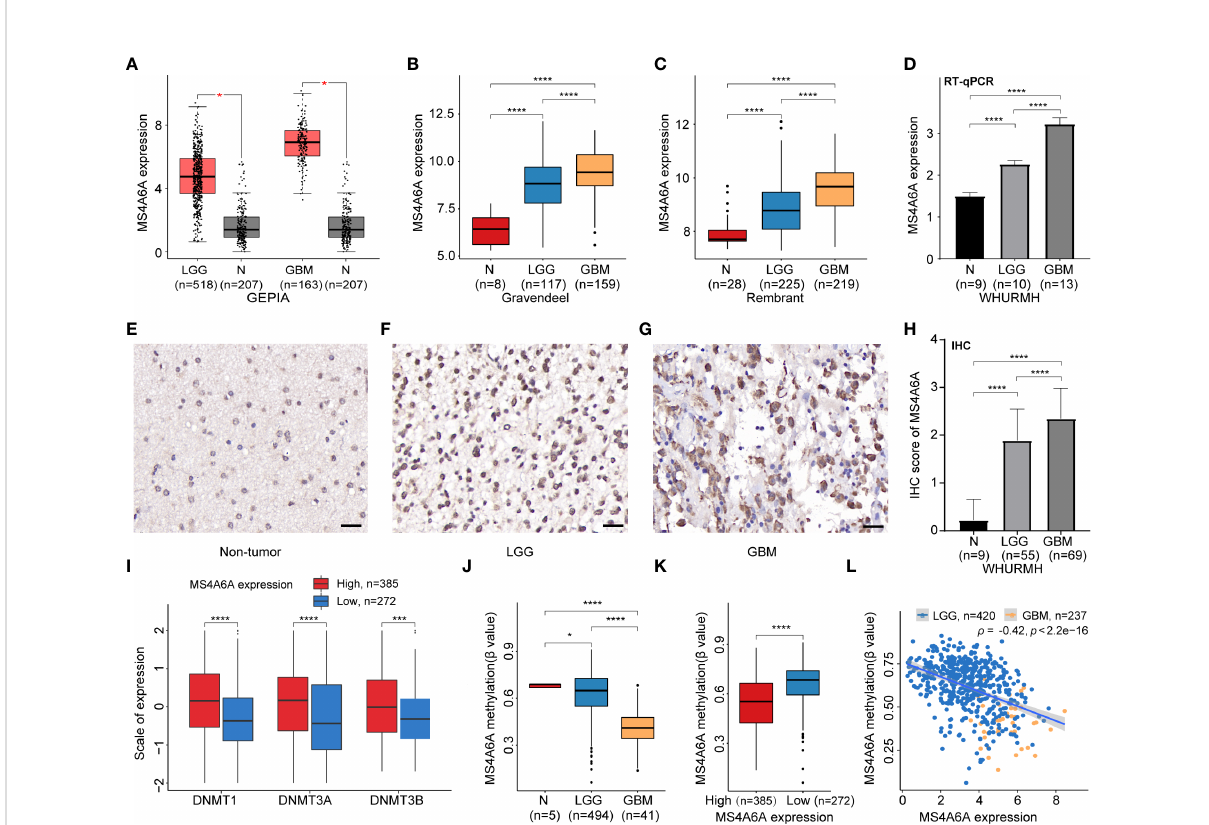
FIGURE 1 Expression and methylation analysis of MS4A6A in glioma.MS4A6A is upregulated in glioma explored based on public data (A-C) and validated by RT-PCR (D) ; representative IHC staining images of normal control (E) , LGG (F) , and GBM (G) ; scale bar, 20 m m. GBM and LGG samples had higher IHC scores than normal samples (H) . DNA methyltransferases are upregulated in the high MS4A6A expression group; the expression pro fi les were Z score normalized (I) . The MS4A6A methylation level correlates negatively with glioma WHO grade (J) and demonstrated differences between subgroups according to MS4A6A expression (K) . MS4A6A methylation has a negative impact on its mRNA expression (L) . p -values were obtained from the Wilcoxon test (A – C, I – K) and t -test (D – H) (bar plots show means ± SD; ns, p > 0.05, * p < 0.05; *** p < 0.001; **** p <